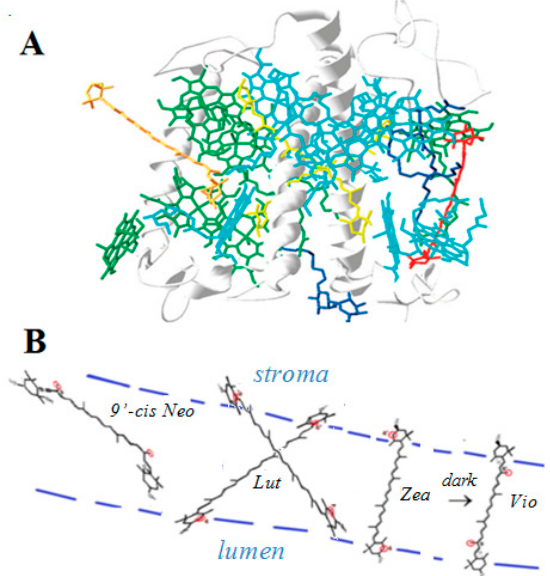
Figure 6. ( A ) LHCII [32] showing the location of the four carotenoids: zeaxanthin (under light) or violaxanthin (under dark) in red, two lutein molecules in a cross position in yellow, and 9’- cis neoxanthin in orange. ( B ) Schematic diagram of the location of the four carotenoids in LHCII indicating the most favorable proton loss in red. Proton loss can occur off the ends of the radical cations of zeaxanthin (Zea) and lutein (Lut), also enabled by the nearby aqueous lumen and stroma. Proton loss off the ends of the radical cations of violaxanthin (Vio) or 9’- cis neoxanthin (9’- cis Neo) is prevented by their structures and by embedment in the hydrophobic region.